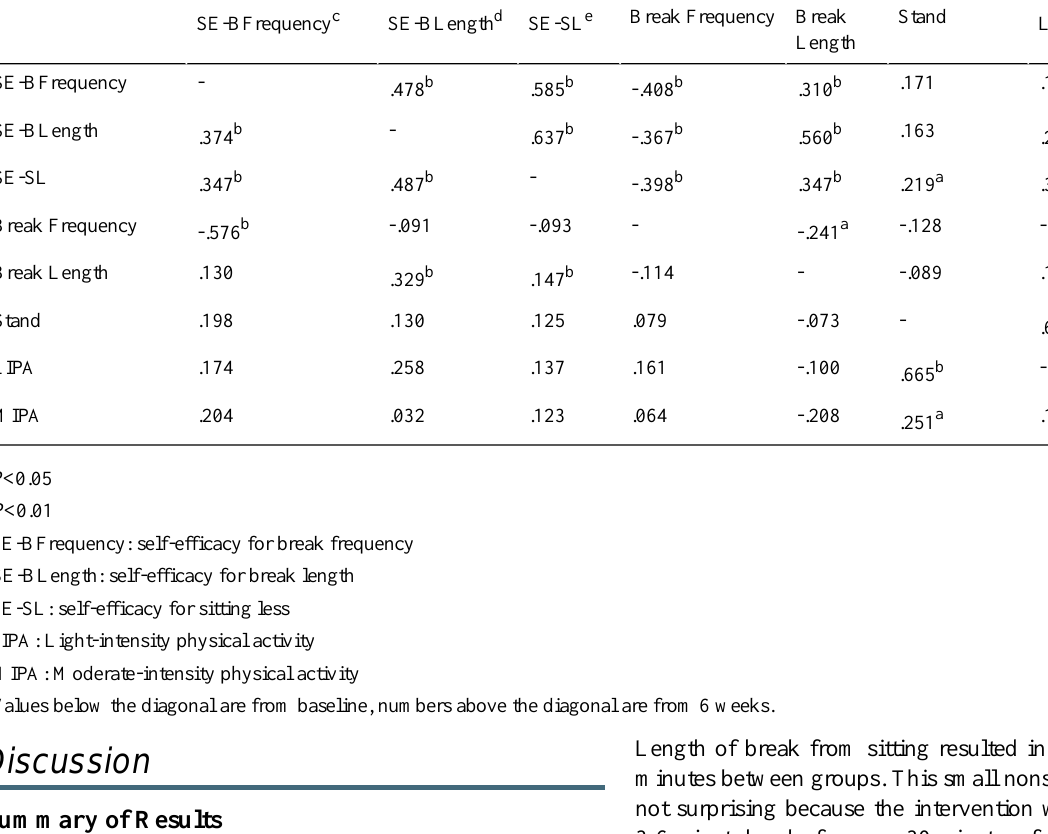
Table 2. Correlation between self-efficacy and target behaviors at baseline and 6 weeks